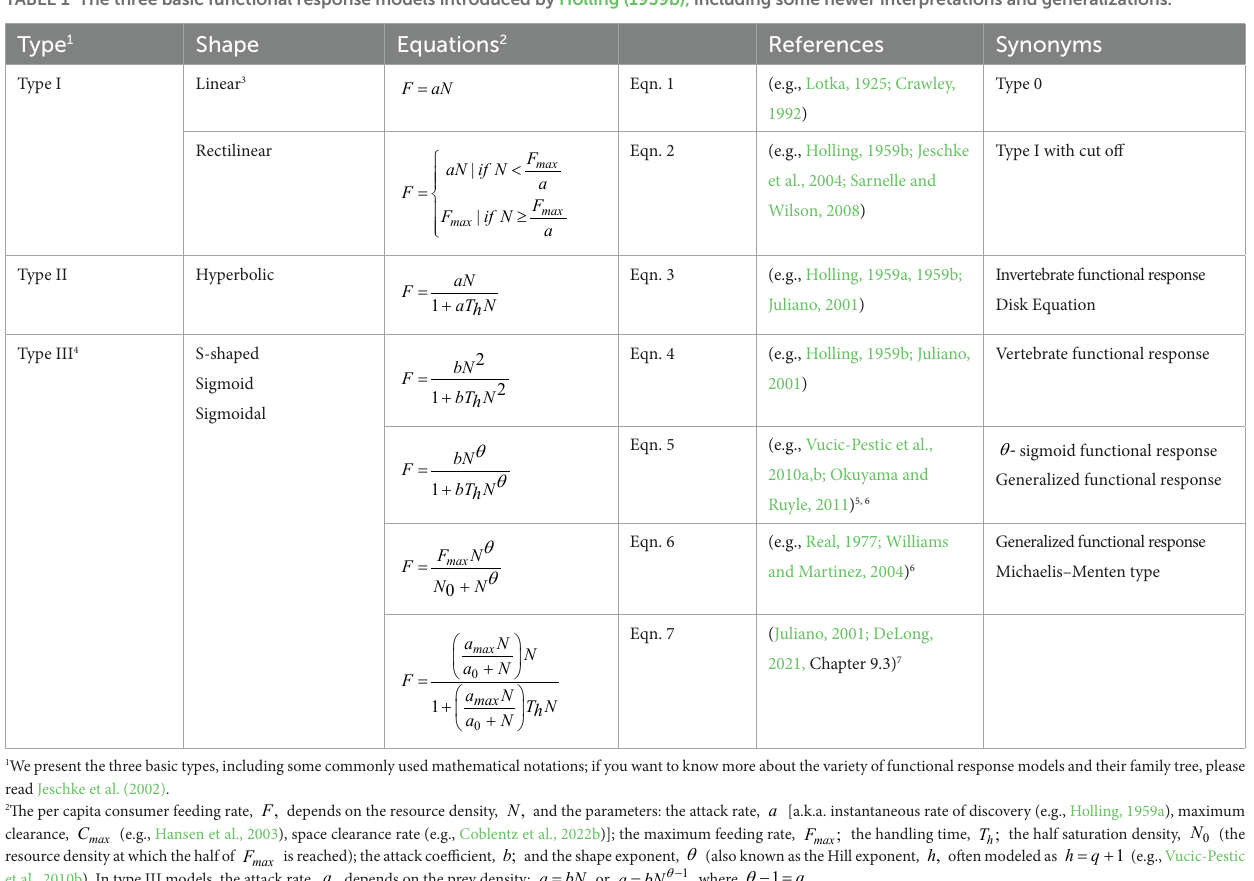
TABLE 1 The three basic functional response models introduced by Holling (1959b), including some newer interpretations and